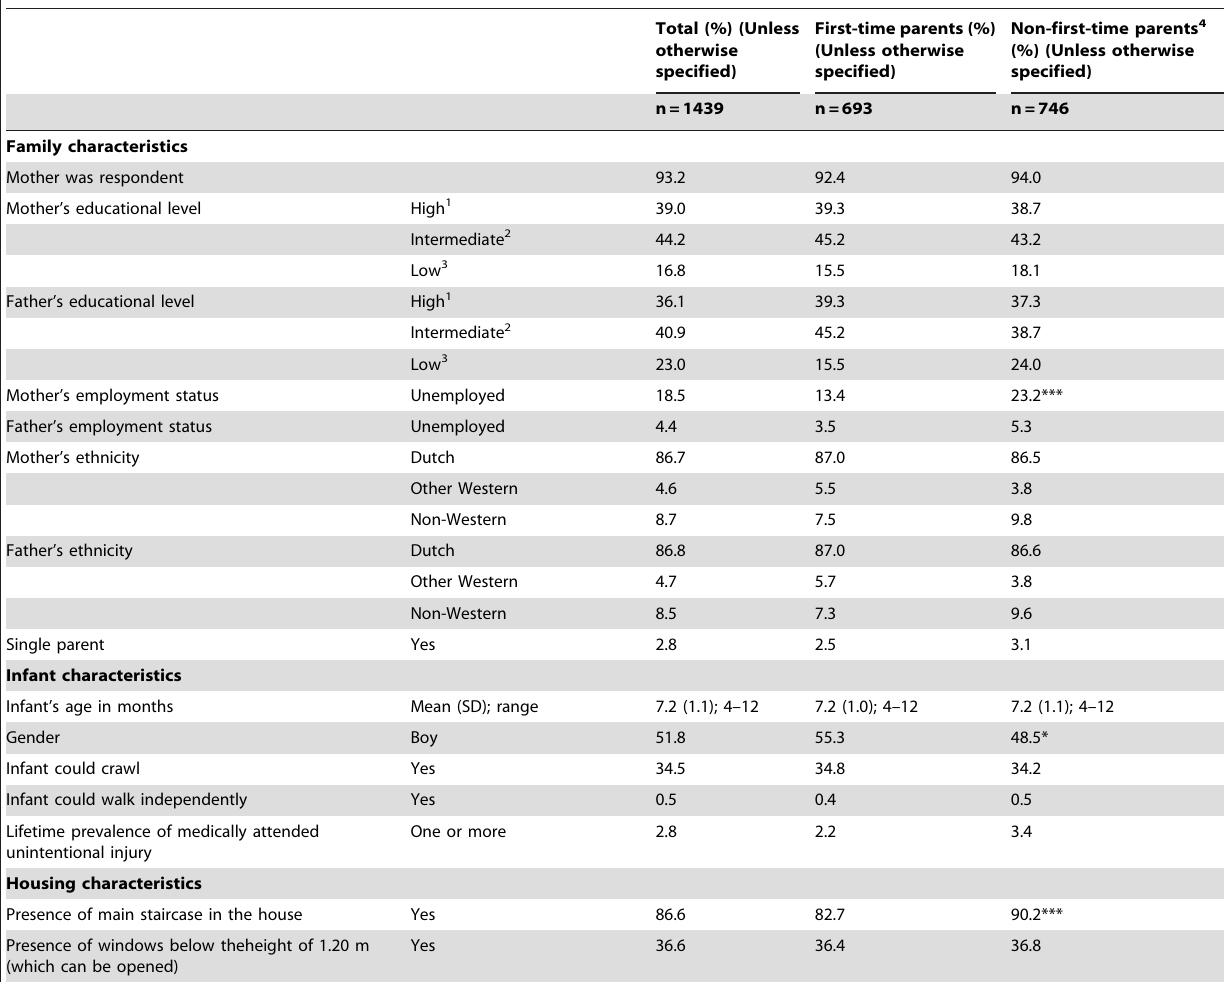
Table 1. Family, infant and housing characteristics, divided by number of children (n